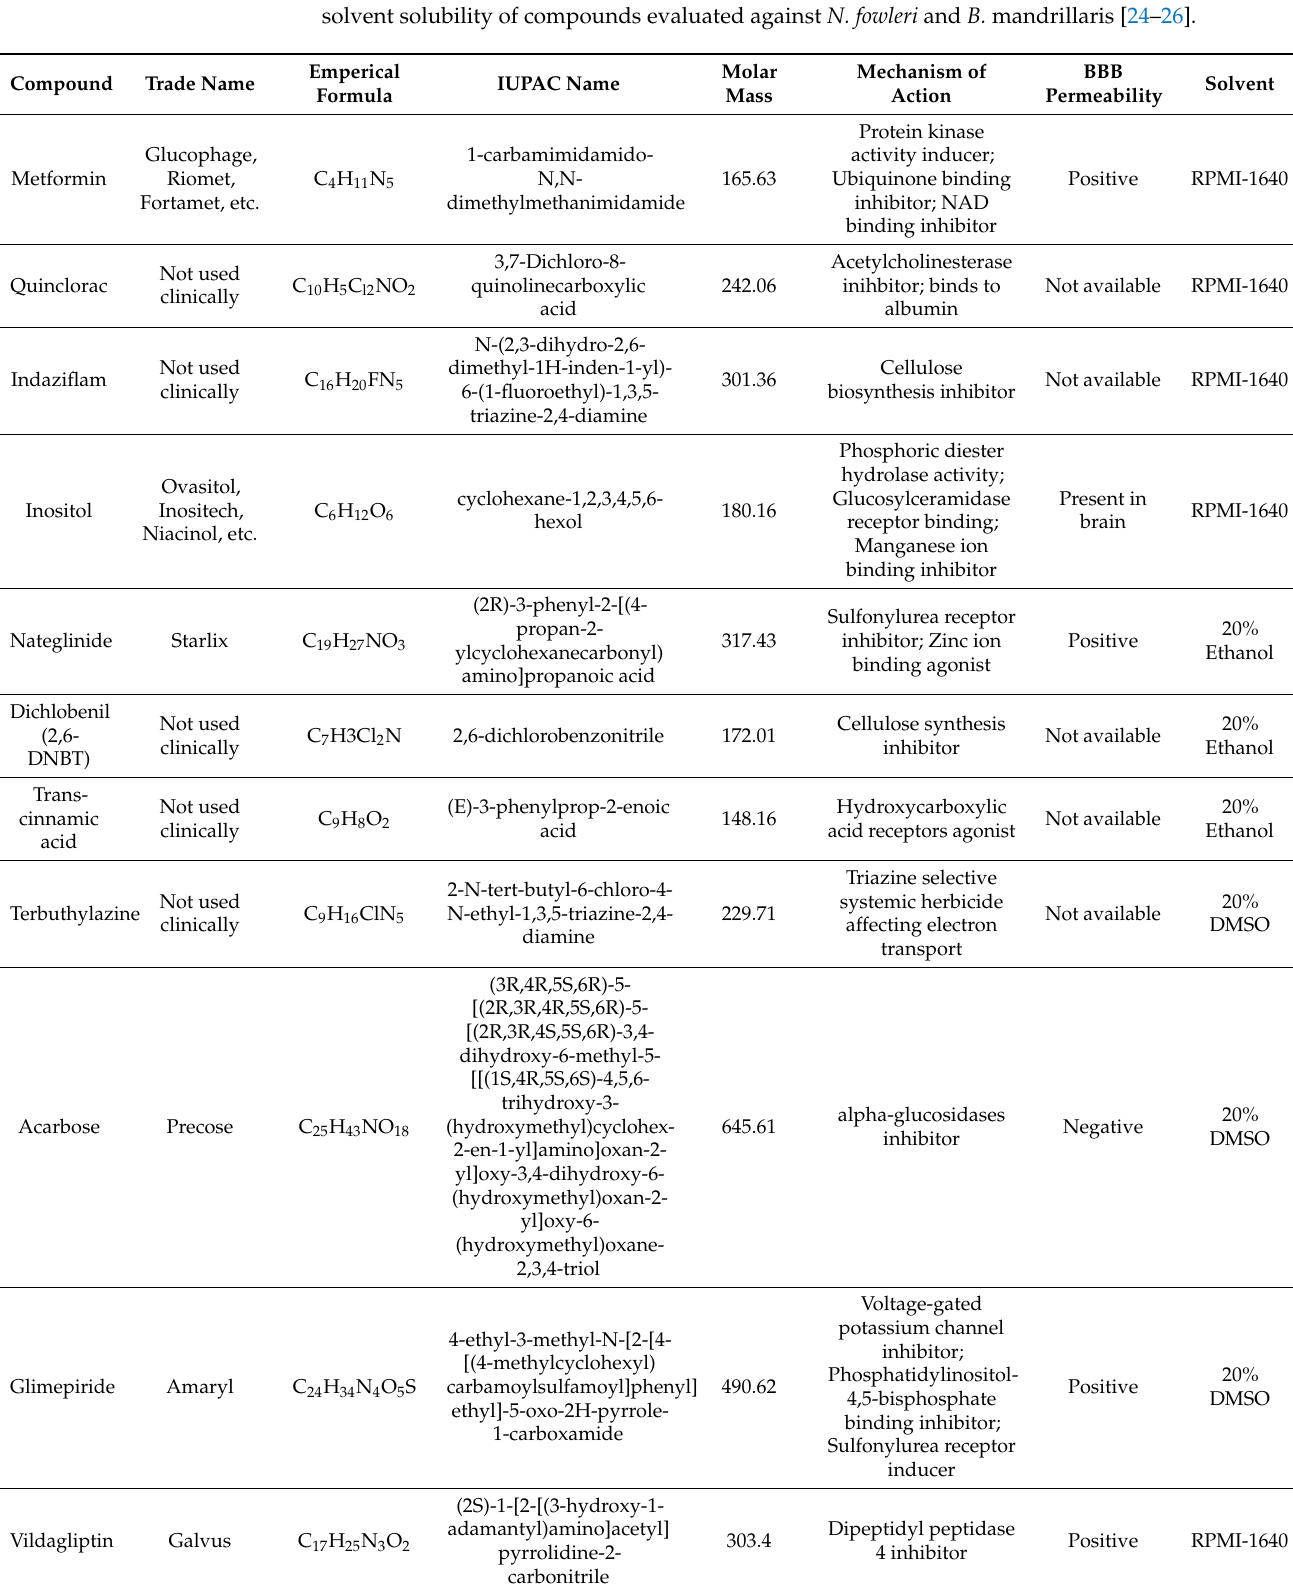
Table 1. Chemical nomenclature, empirical formula, class, mechanism of action, molar mass